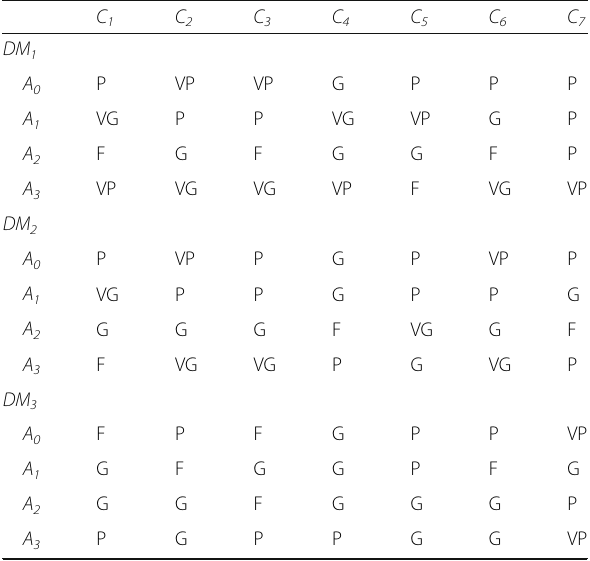
Table 2 Rating of route alternatives with respect to criteria assessed by decision